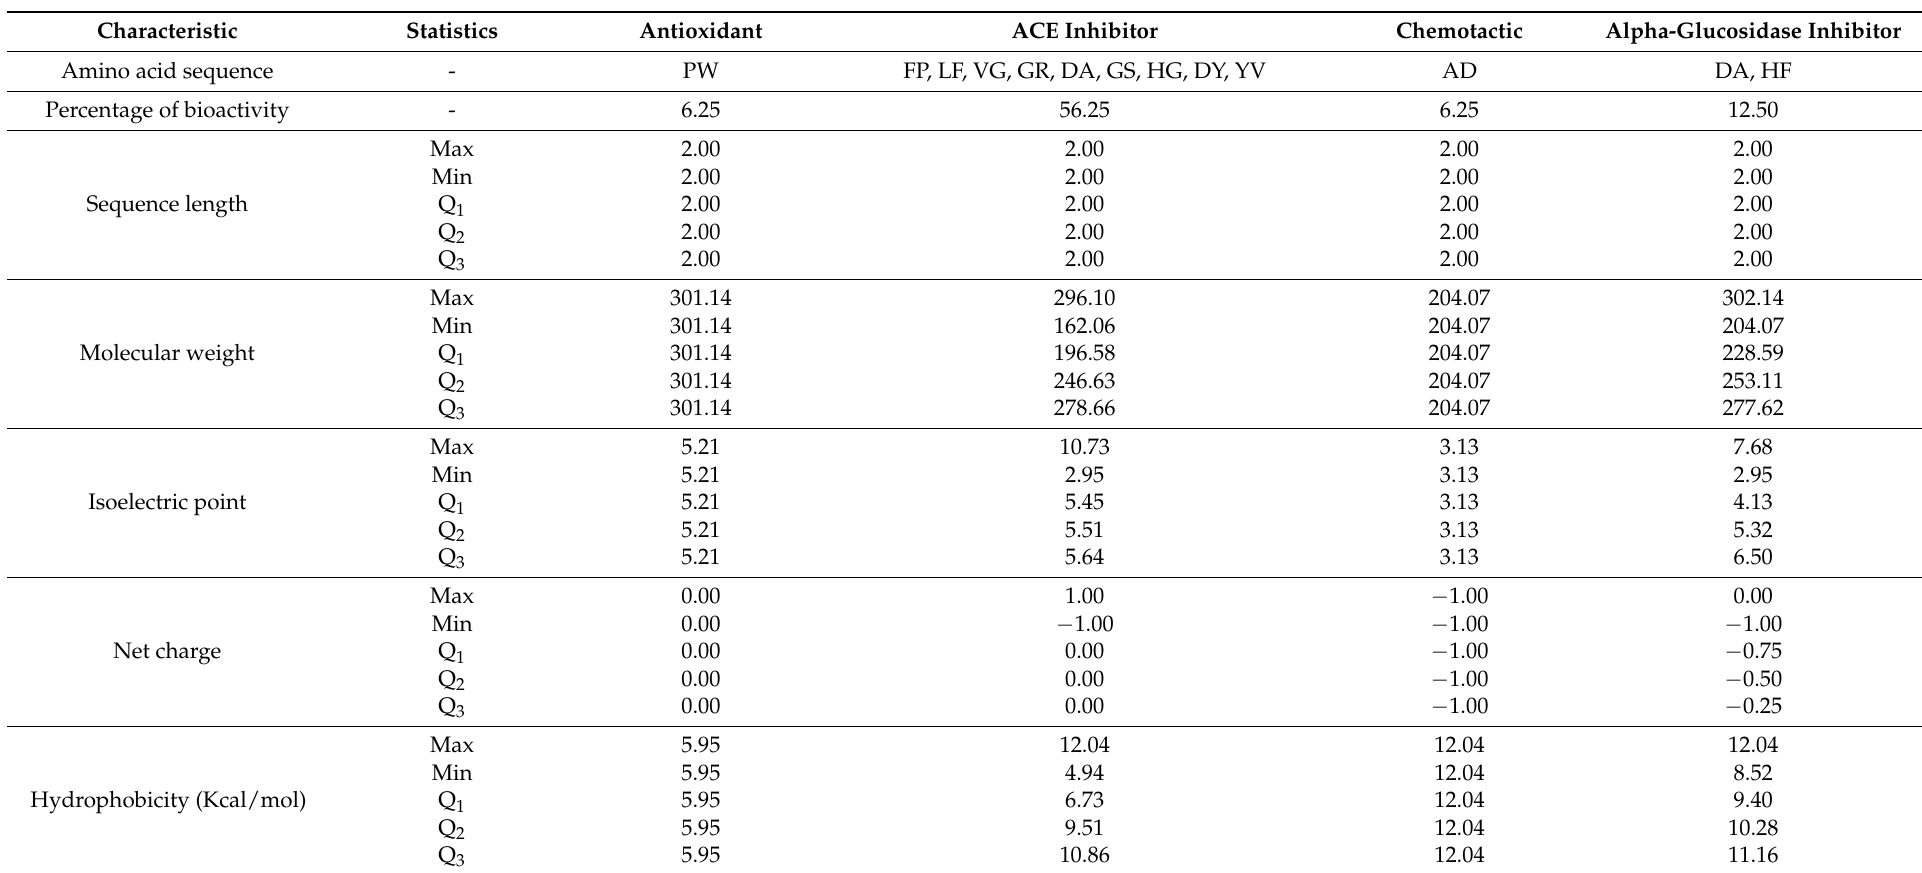
Table 4. The characteristics of the bioactive peptides in the PBN fraction of <3